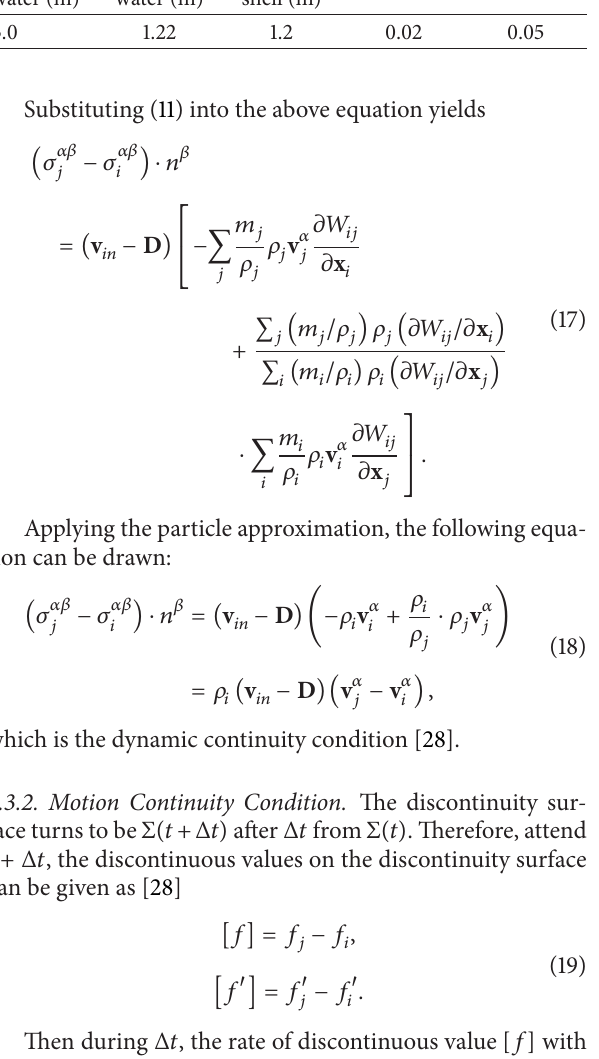
Table 7: Parameters of single cylindrical shell. Outside Inside radius of radius of water (m) water (m)